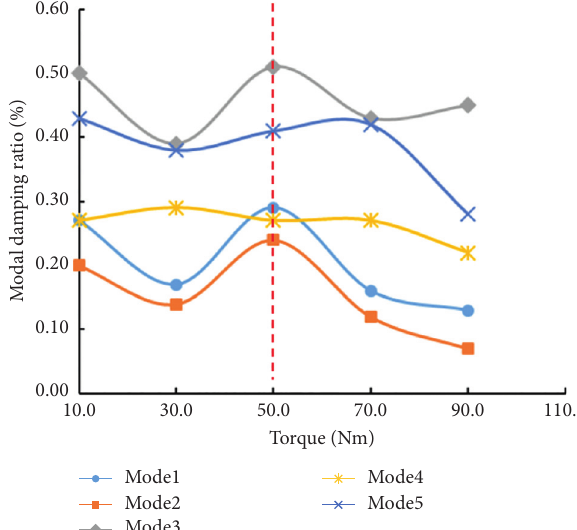
Figure 8: Modal testing results of Case 2: modal damping ratio versus preload on M20 bolt.